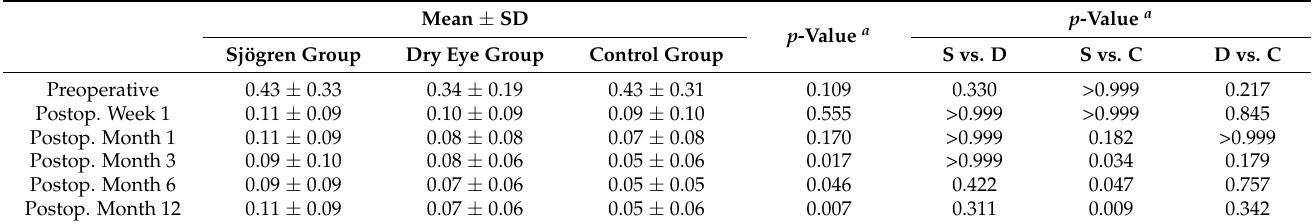
Table 5. Preoperative and Postoperative UDVAs (Log